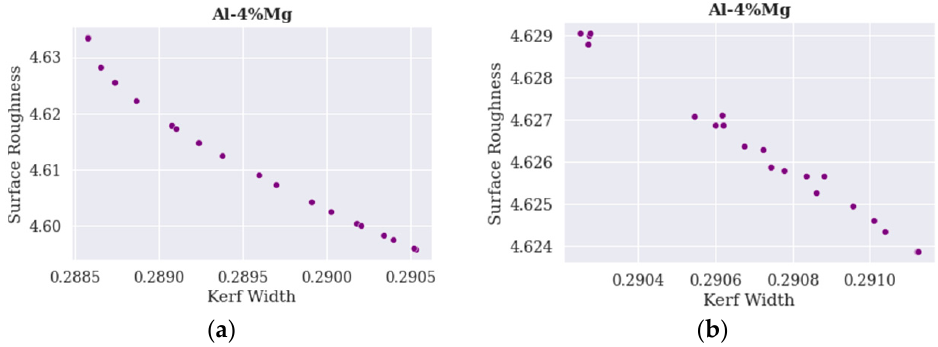
Figure 5. Pareto optimal solutions for Al-4%Mg by ( a ) NSGA-II, and ( b ) MOPSO. For Al-4%Mg sample, kerf width and surface roughness are low when 9–10 A current, 50 µs of pulse on time, and 30–32 V of gap voltage according to the Pareto-optimal solutions. For Al-4%Mg-2%MoS 2 sample, Figure 6a,b shows the Pareto optimal solutions obtained by NSGA-II and MOPSO algorithms.